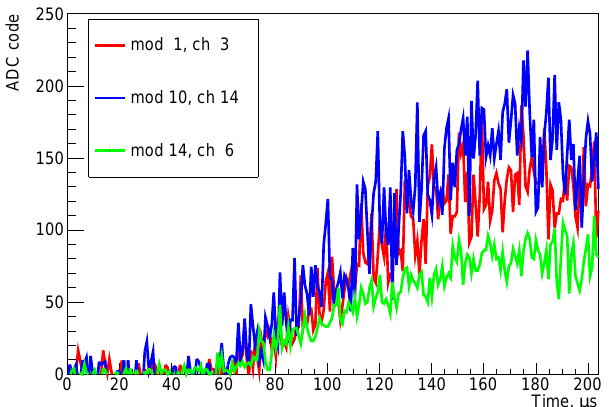
Figure 5. Waveforms of a “monotonously growing” flash in three pixels. The same kind of waveforms is observed in the majority of